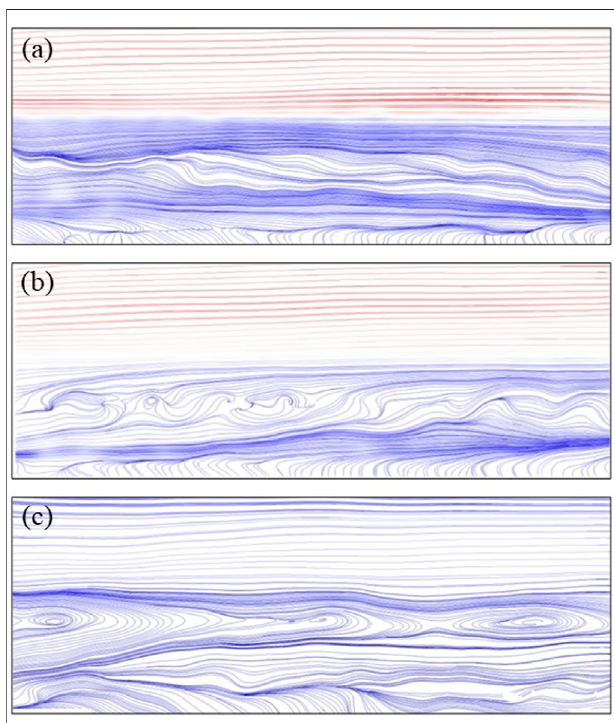
FIGURE 5 | PIV snapshots of the streamlines on the central plane at x = 5 z i away from the inlet at different values of U 2 with Q S = 40 L/h and ρ 0 = 1,060 kg/m 3 : (A) U 2 = 0.01 m/s (case 1), (B) U 2 = 0.02 m/s (case 2), and (C) U 2 = 0.04 m/s (case 3), respectively.